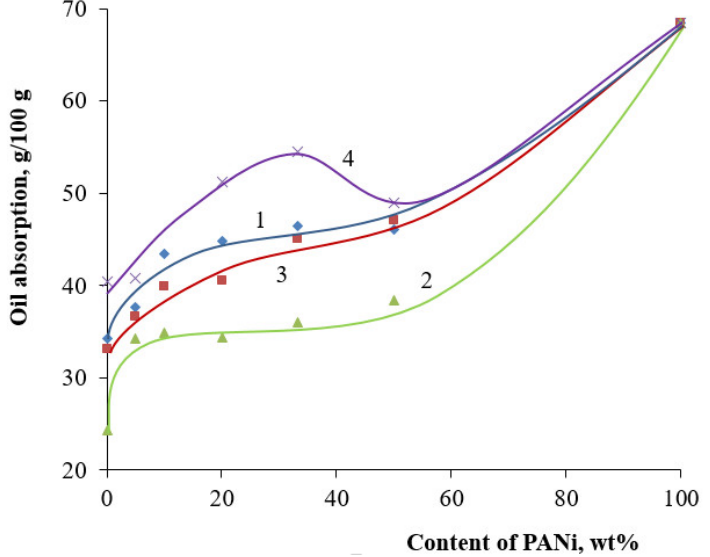
Figure 14. Core/shell pigment oil absorption vs. PANi content doped with hydrochloric acid. Core: (1)—kaolin, (2)—talc, (3)—bentonite, (4)—muscovite.